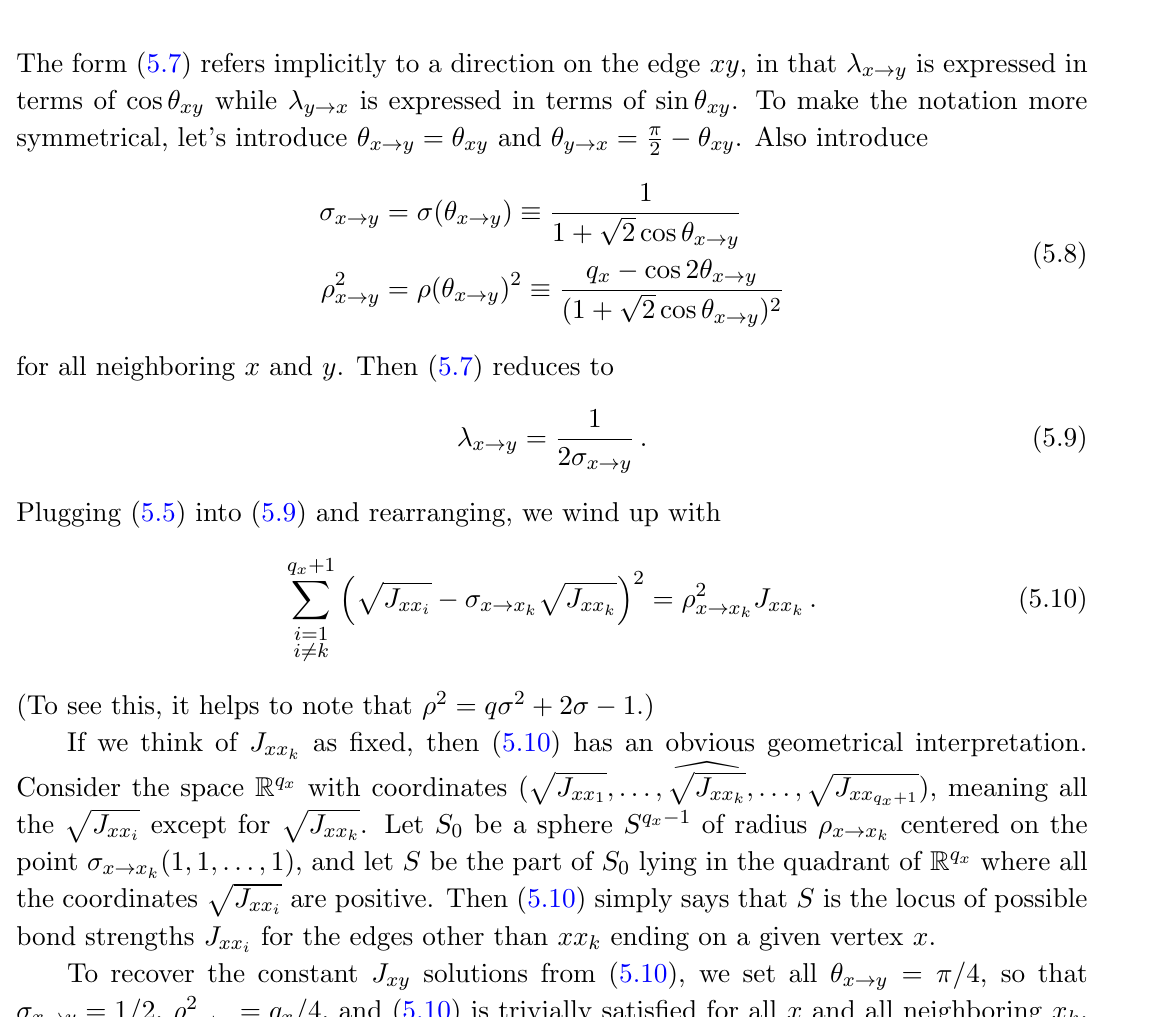
Figure 5 . The \local solution circle" for edge xy . The physical solution subspace lies inside the interval (cid:18) xy 2 ( (cid:0) (cid:25)= 4 ; 3 (cid:25)= 4) (the solid blue